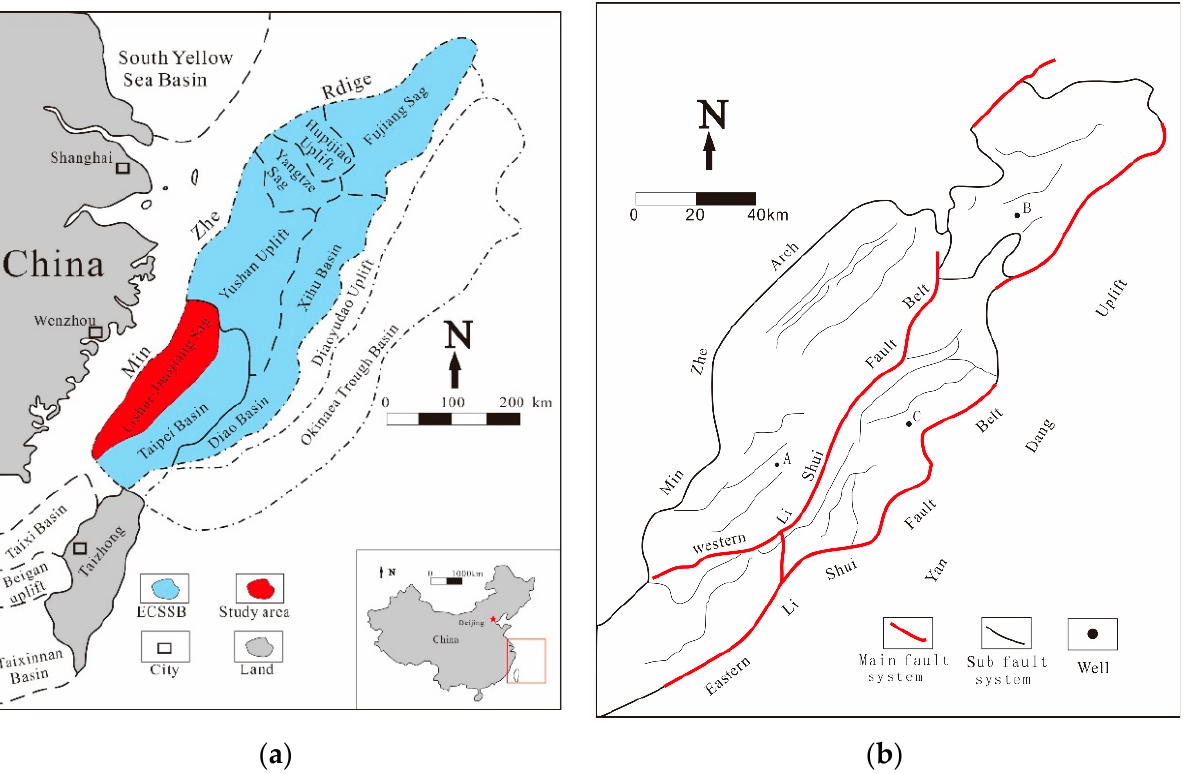
Figure 1. ( a ) Tectonic location of the East China Sea Shelf Basin (modified after [51]). ( b ) Structural units of the Lishui–Jiaojiang Sag (modified after [51]).